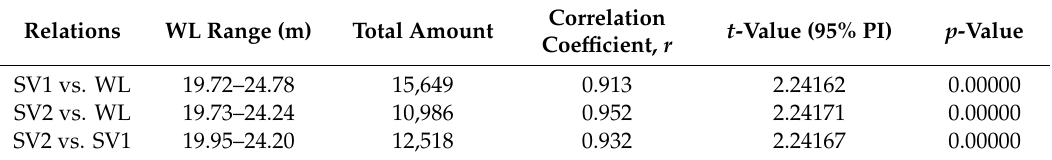
Table 2. Characteristics of samples selected from 2012–2014 at Yenfong Bridge.